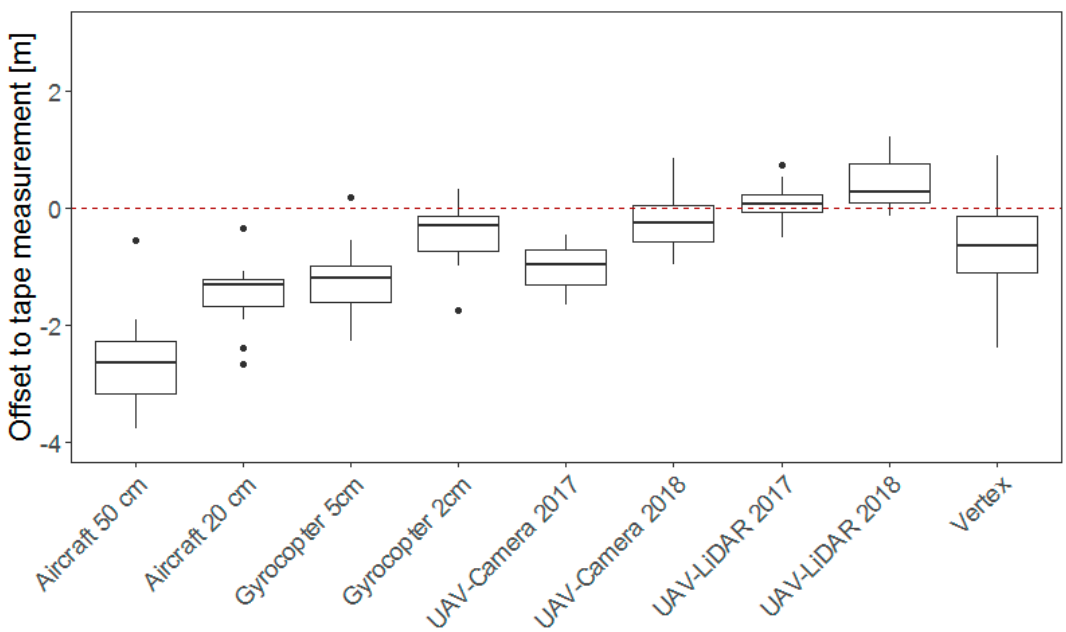
Figure 5. Boxplot analysis for the remote sensing datasets and the terrestrial measurement via Vertex. Tree heights recorded via measuring tape were assumed as the real tree heights.